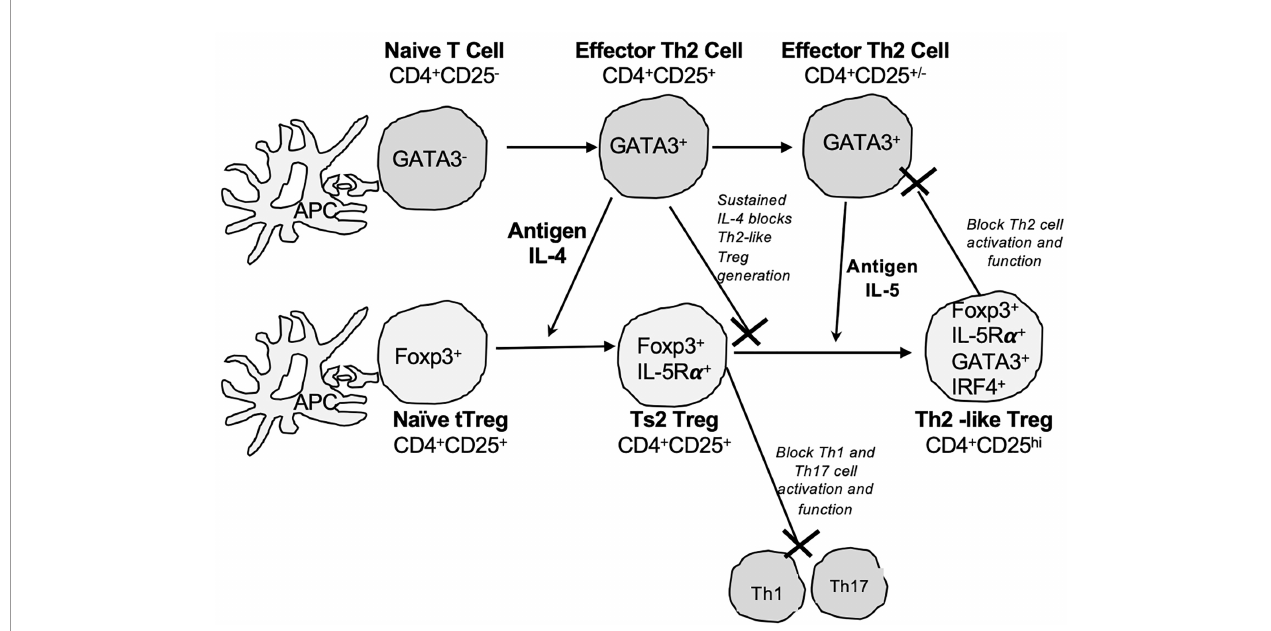
FIGURE 1 | Pathways for activation of naïve CD4 + CD25 + Foxp3 + Treg by Type-2 cytokines and alloantigen. We propose activation of naïve/resting thymic CD4 + CD25 + Treg (tTreg) is driven by cytokines produced by activated effector T cells. The Type-2 cytokine and alloantigen activation pathway of tTreg parallels the activation of effector Th2 cells. Our hypothesis is based on the physiology of immune response. IL-4 is only produced by Th2 cells early in an immune response and late in the response IL-4 is replaced by other Th2 cytokines including IL-5 and IL-13. Our proposed model is that naïve T cells in the rejection response are activated to Th2 cells as well as Th1 cells. Th2 cells express transcription factor GATA-3 and produce Th2 cytokine IL-4 (Top row) in early stages of immune response. This IL-4 activates other naïve T cells to expand the immune response. In parallel, IL-4 also activates naïve/resting CD4 + CD25 + Foxp3 + Treg (tTreg) in a polyclonal fashion and this activation does not require IL-2. tTreg express IL-4R a and can recognize graft alloantigen in the presence of IL-4 get activated to alloantigen-speci fi c Treg that are induced to express IL-5R a , the speci fi c receptor for IL-5 (Bottom row). We call these activated antigen-speci fi c CD4 + CD25 + Foxp3 + Treg Ts2 cells (29, 30). Ts2 cells diminish the immune response by inhibition of Th1 and Th17 cells promoting polarization to a Type 2 effector response (30). A sustained Th2 response results in production of IL-5 from Th2 cells (GATA-3 + ), and diminished IL-4 production. In the second step of activation is IL-5 in presence of speci fi c stimulating alloantigen promoting expansion of Ts2 (IL- 5R a + Foxp3 + ) to Th2-like Treg. Th2-like Treg express mRNA for Foxp3, Gata-3 , Irf4 and Il5 . Th2-like Treg do not express key markers of Th1-like Treg such as tbet , Ifng. Ifngr or Il12rb2 . The presence of IL-4 during late stage of immune response inhibits induction of Th2-like